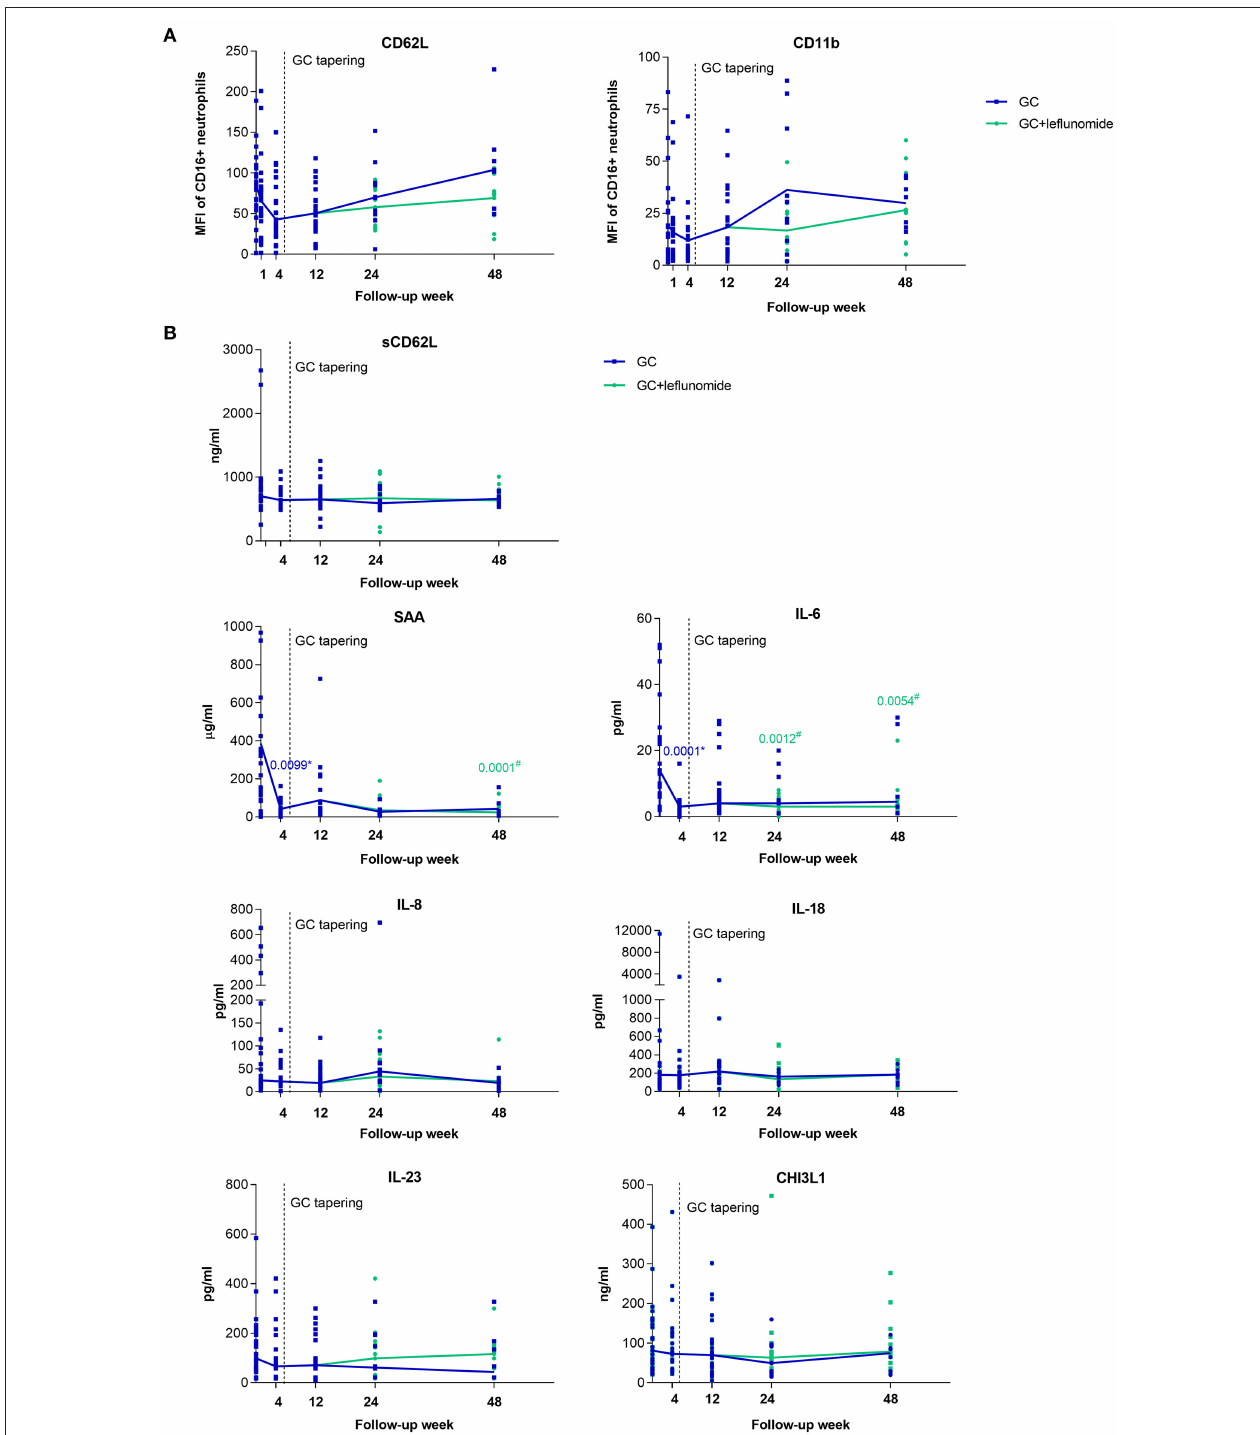
FIGURE 4 | Surface expression of CD62L and CD11b on neutrophils (A) and serum levels of selected analytes (B) from GCA patients who responded to therapy ( n = 25), at baseline visit (To) and 1, 4, 12, 24, and 48 weeks of follow-up. After pre-treatment sampling (time point 0), all patients received GC and therapy tapering started after week 4 (indicated with vertical dotted line). After week 12 some of the patients (15/25) received leflunomide, in addition to GC therapy (green). The horizontal lines connect the medians from each follow-up time point. GCA, giant cell arteritis; MFI; median fluorescence intensity. * indicates statistical significance between the corresponding timepoint and T 0 in patients receiving GC monotherapy (blue); # indicates statistical significance between the corresponding timepoint and T 0 in patients receiving GC in combination with leflunomide